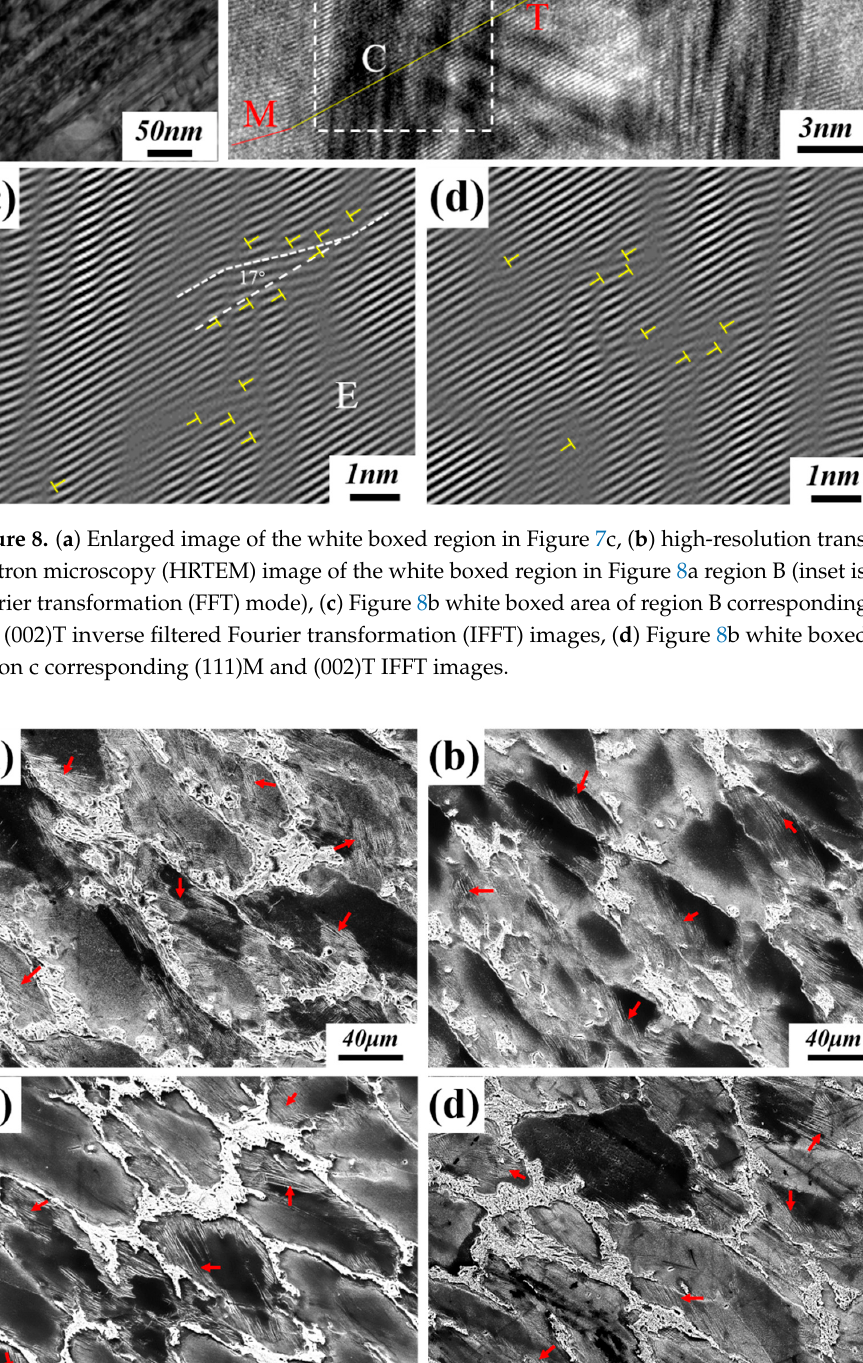
Figure 9. SEM images of the solid CuSn10P1 alloy at a strain rate of 10 s − 1 and isothermal compression at different deformation temperatures, deformed to ε = 0.3: ( a ) 350 °C, ( b ) 380 °C ( c ) 410 °C, ( d ) 440 °C. (Arrows indicate deformation marks).